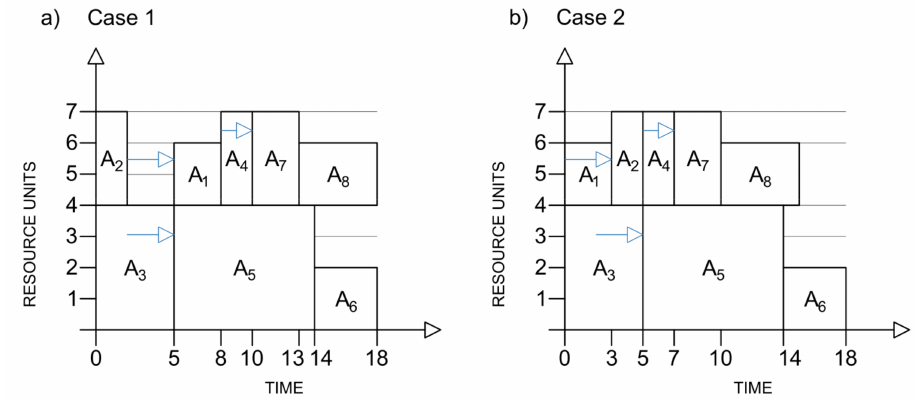
Figure 4. Baseline schedules with additional resource constraints for ( a ) Case 1 with the highest SM value and lower profit than in Case 2, and ( b ) Case 2 with the highest profit and lower SM value than in Case 1.